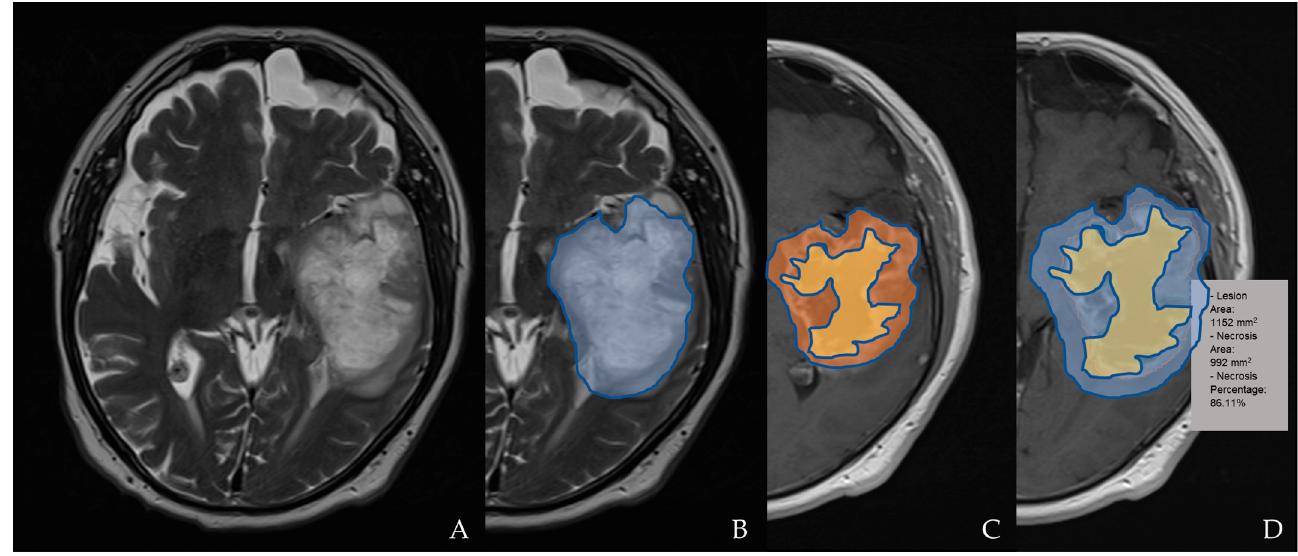
Figure 2. An example of tumor segmentation for necrosis depiction. The segmentation of the T2 hyperintensity region designated as tumor invasion is shown in ( A , B ) on an axial plane (blue); the axial post-contrast T1WI shows segmentation of the necrotic area (yellow) compared to the enhancing tumor (orange; in ( C )) and lesion/tumor area (blue; in ( D )); the necrosis percentage is also calculated in ( D ).